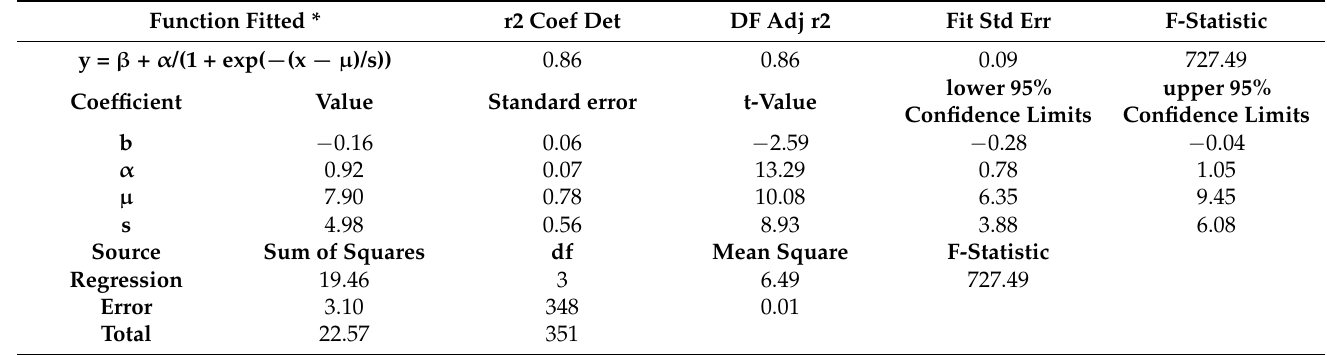
Table 4. Function fitted, determination coefficient (either raw or adjusted) and estimation of the coefficients of the sigmoid shown in Figure 4 and p -values of the general linear mixed model applied to the temporal trend of the cumulative germination of onion seed. Factors were the time (referred as “Time” and included as a class variable), the moment and amount of ethylene applied [Treat] and the Chitosan nested in the ethylene application [Chit(Treat)]. Values at p < 0.05 were indicated in bold. Numerator degrees of freedom are indicated, denominator degrees of freedom were estimated by the Kenward Roger